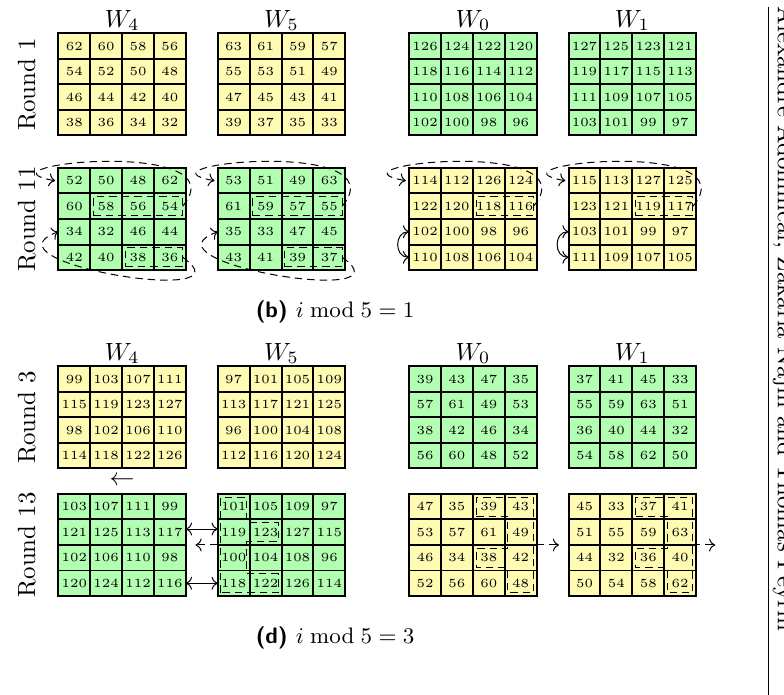
Figure 9: GIFT-128 double/triple key update functions from round i to i + 10, according to the different fixsliced repre- sentations over 5 rounds. Each cell represents a bit, and the numbers in the cells then denote the actual index of that particular bit in the 16-bit key word. Note that i mod 5 = 4 refers to the classical representation. The cell colors match the corresponding slice for the add round key